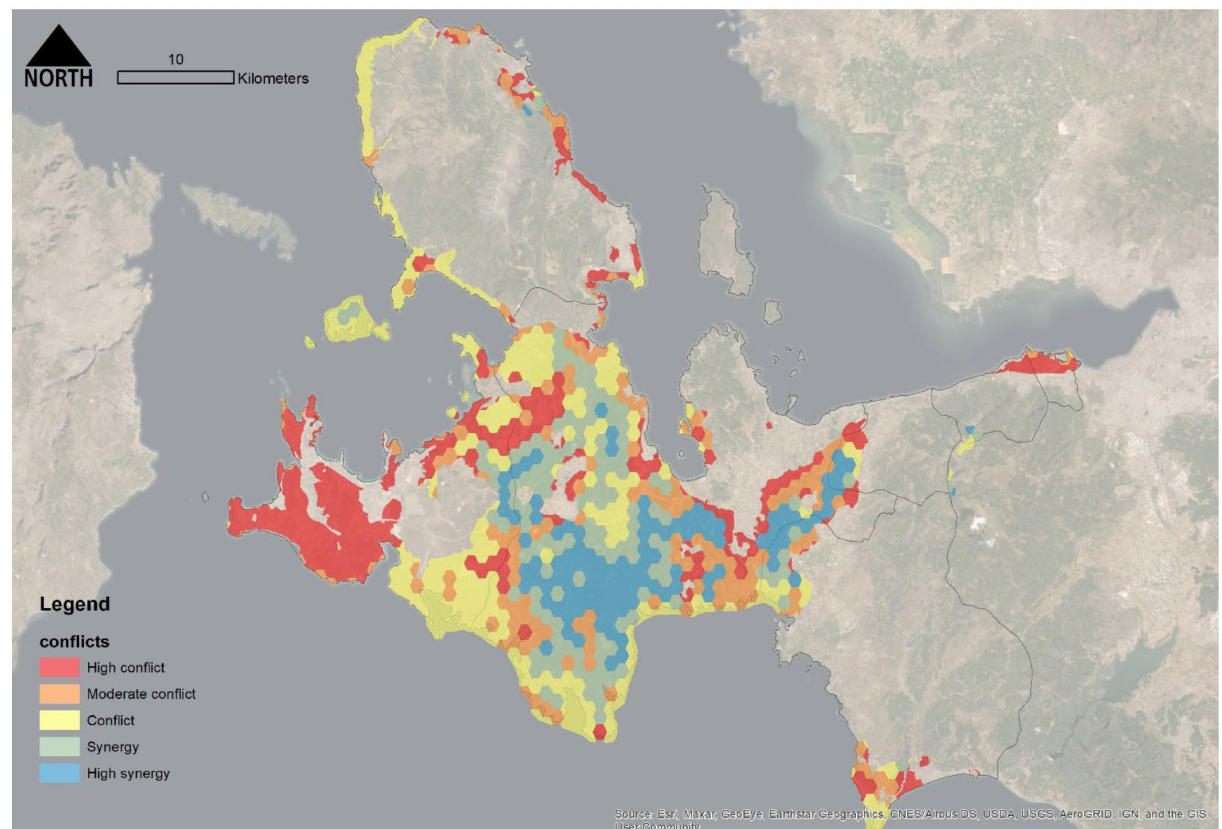
Figure 10. Conflicts and Synergies with the Conservation Zones of the Environmental Regulation